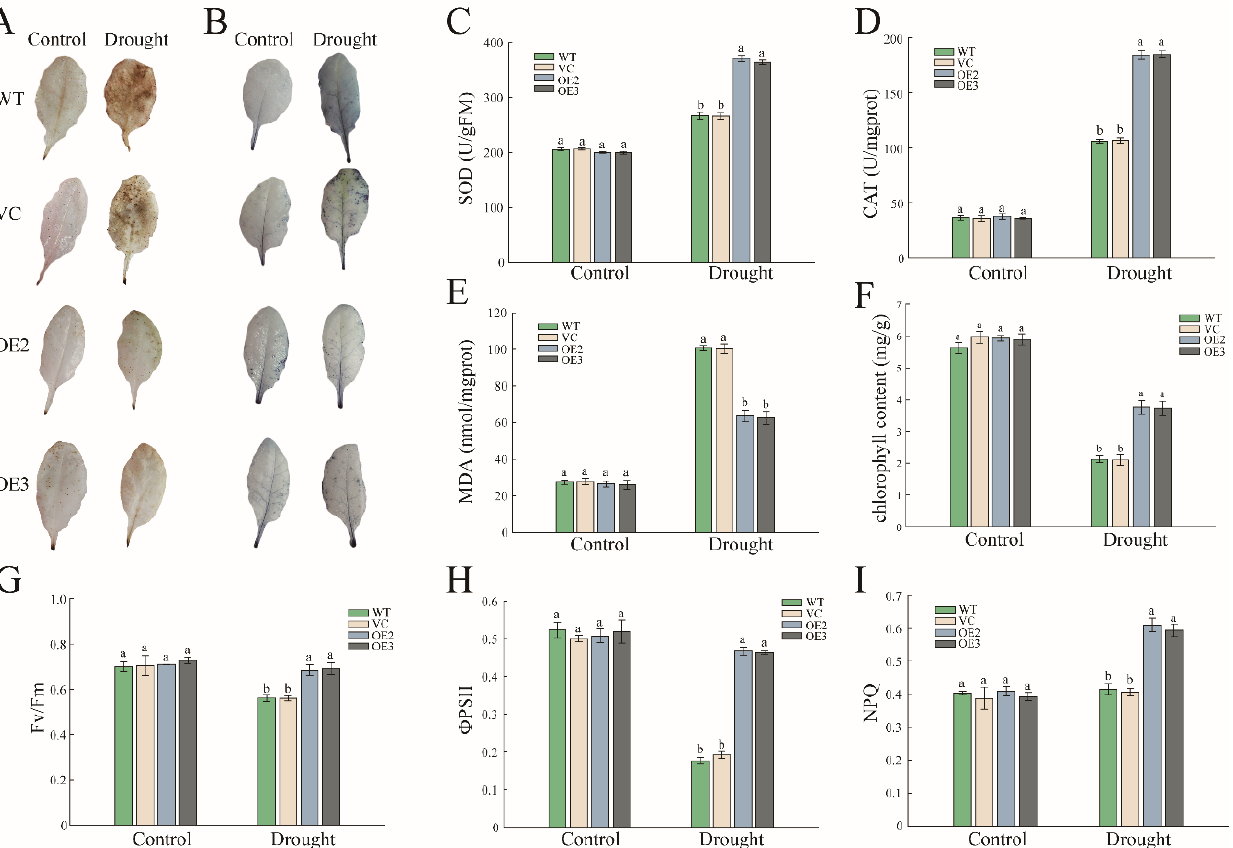
Figure 4. Overexpression of PwNAC11 enhances ROS scavenging ability in transgenic Arabidopsis . ( A ) Histochemical detection of hydrogen peroxide using DAB staining. ( B ) Histochemical detection of superoxide using NBT staining. ( C ) The activity of SOD. ( D ) The activity of CAT. ( E ) The content of MDA. ( F ) The content of chlorophyll. ( G ) Measurement of Fv/Fm under normal and drought conditions. ( H ) Measurement of Φ PSII under normal and drought conditions. ( I ) Measurement of NPQ under normal and drought conditions. Different letters indicate significant differences at p -value < 0.05.